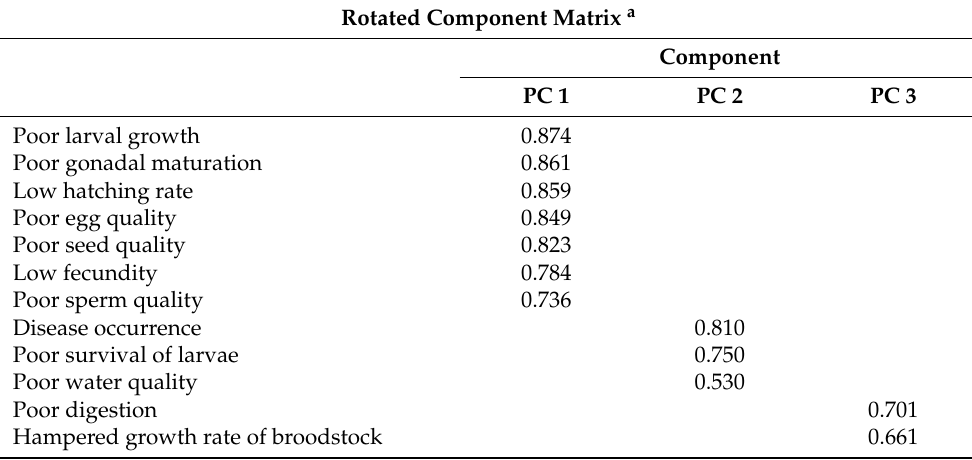
Table 6. Rotated component matrix and correlation coefficients of the variables with significant components for characterizing climate change impacts on fish hatchery operation. Rotated Component Matrix a